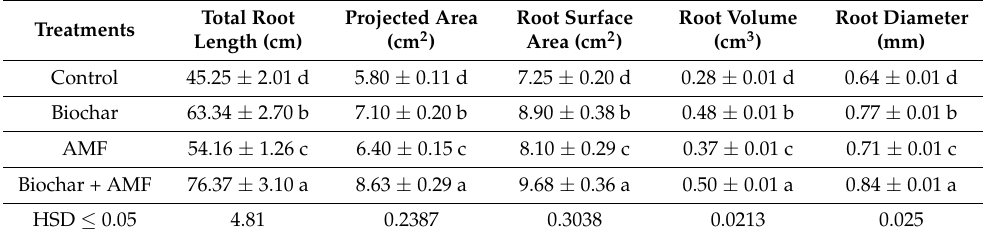
Table 3. Impact of biochar and AMF on root morphological traits of fenugreek.